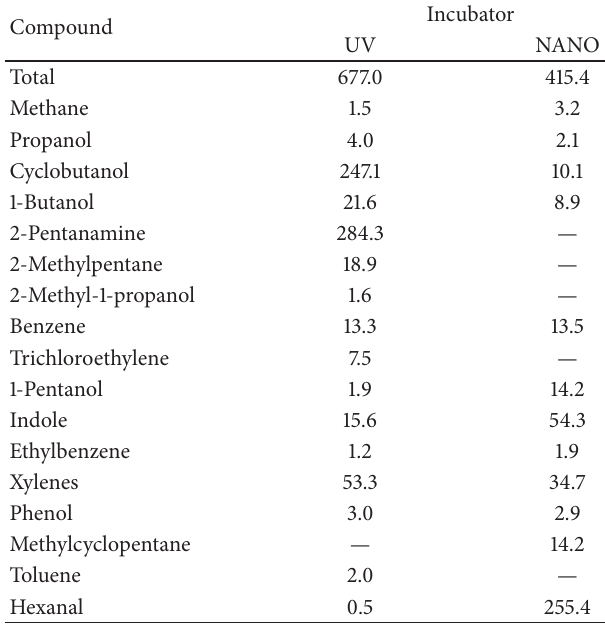
Table 11: VOC concentrations in the air inside the incubators on the 17th day of incubation [ 𝜇 g/m 3 ].